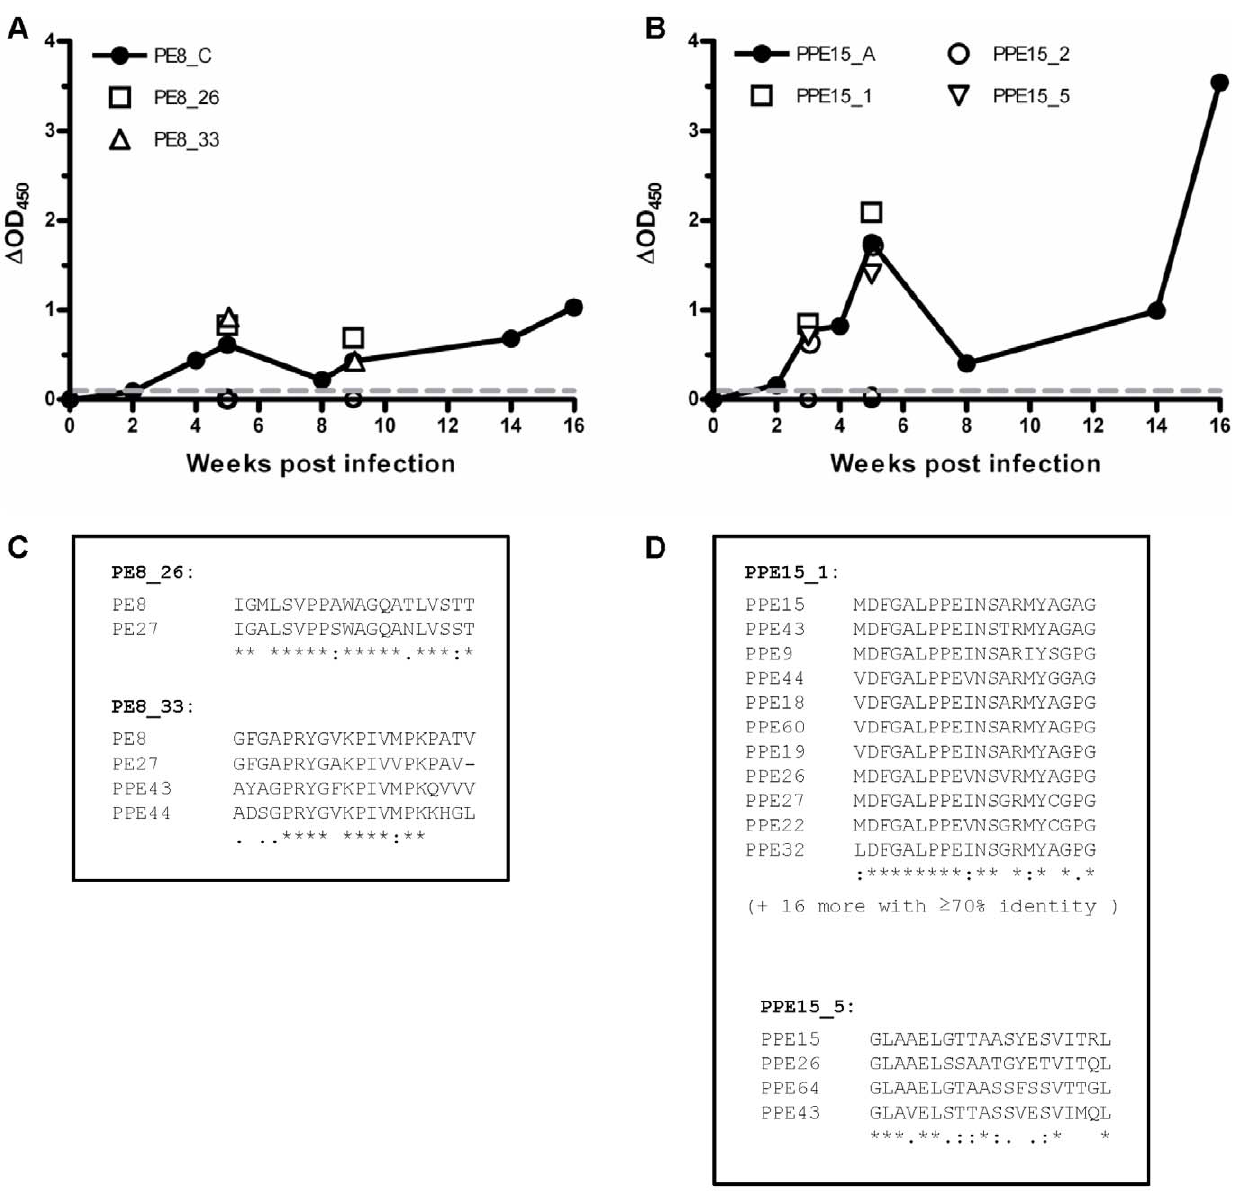
Figure 6. Whole blood IFN- U responses to individual and pooled PE/PPE peptides. Peptide pools eliciting positive responses were further analysed by assessing the contribution of each constituent peptide at 3, 5 or 9 weeks post-infection . Representative data are shown for peptides corresponding to (A) One pool derived from PE8, and (B) One pool derived from PPE15. The solid lines represent the temporal response to a peptide pool, while individual symbols correspond to individual peptides. (C) and (D) BLASTP homology searches were performed with peptides which elicited positive responses, and closest matches are shown in a CLUSTALW alignment.